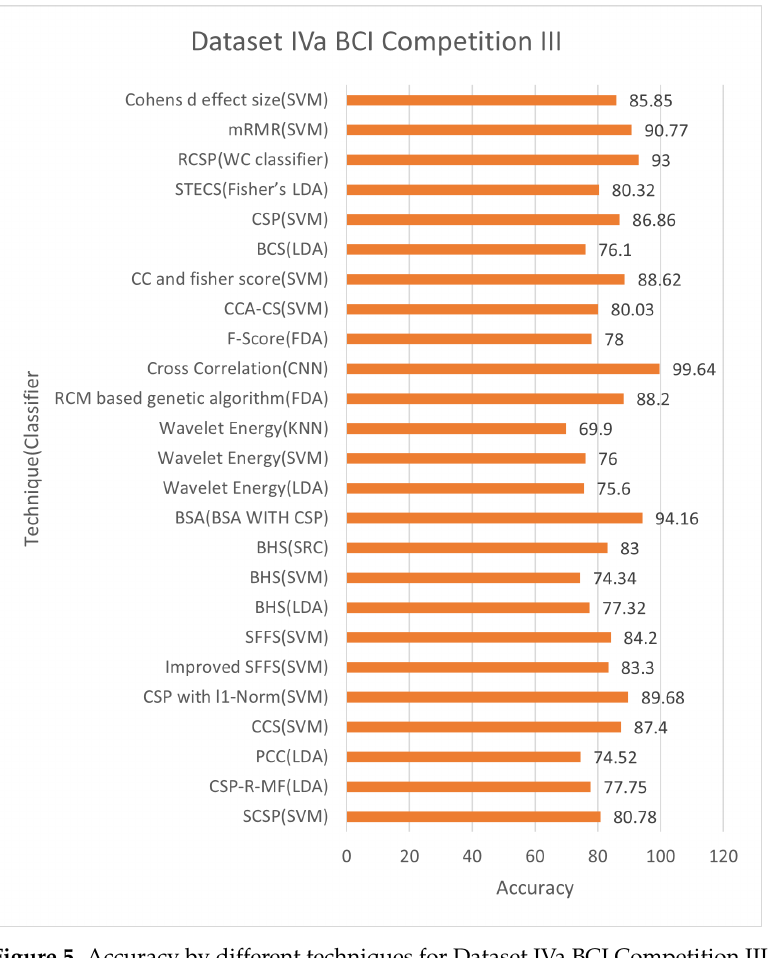
Figure 5. Accuracy by different techniques for Dataset IVa BCI Competition